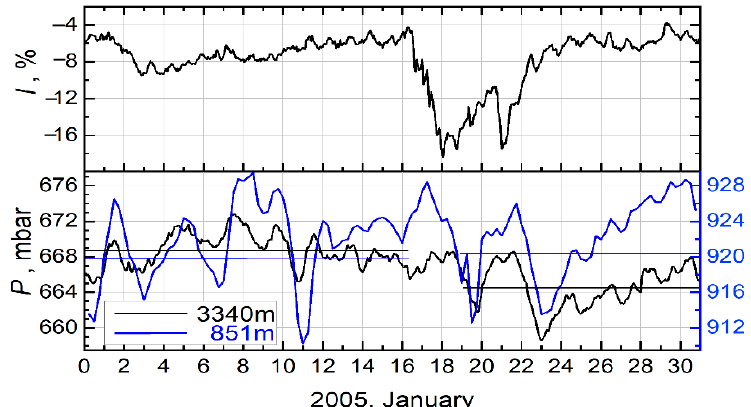
Figure 10. Variations in the intensity of the neutron component of cosmic rays and atmospheric pressure at different heights.